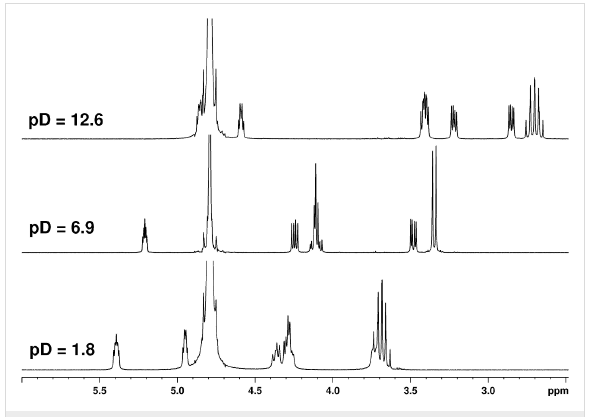
Figure 4: The aliphatic part (pyrrolidine protons) of the 1 H NMR spectra of 9 measured in D 2 O at different pD